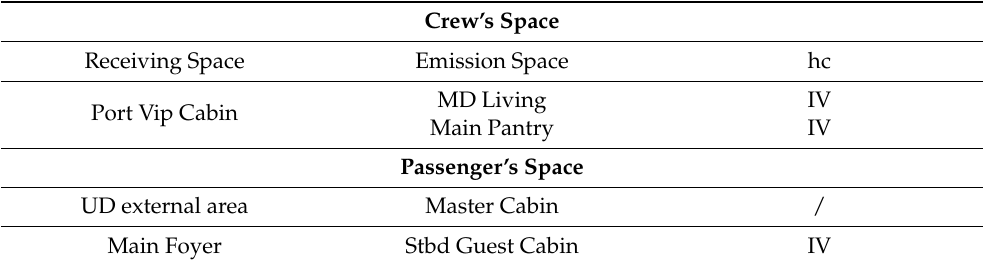
Table 9. Impact level classification with the Germanischer Lloyd